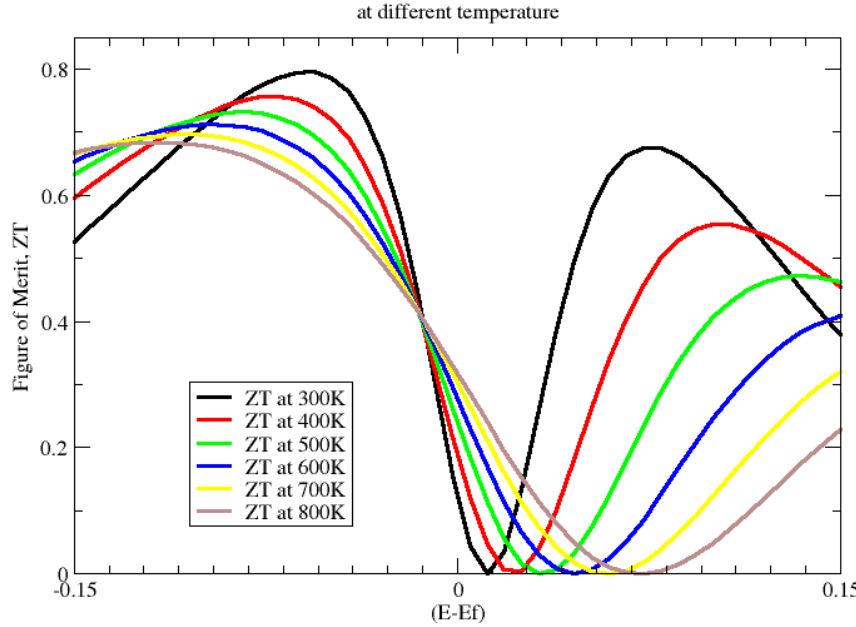
Figure 5. High Figure of Merit in VIrSi half-Heusler alloys from 300 to 800